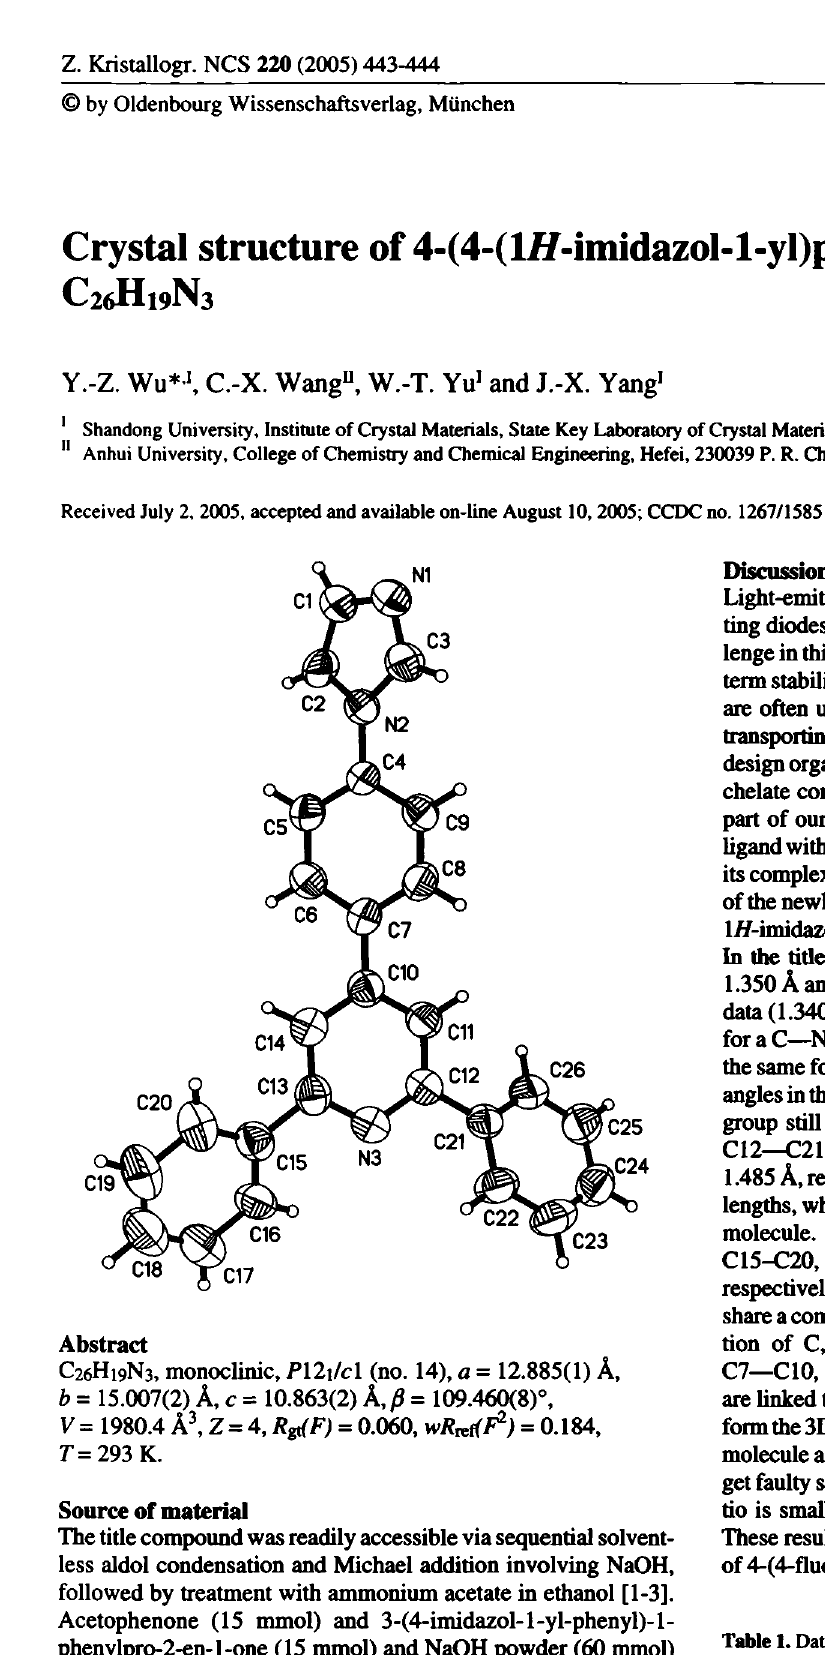
Table 1. Data collection and